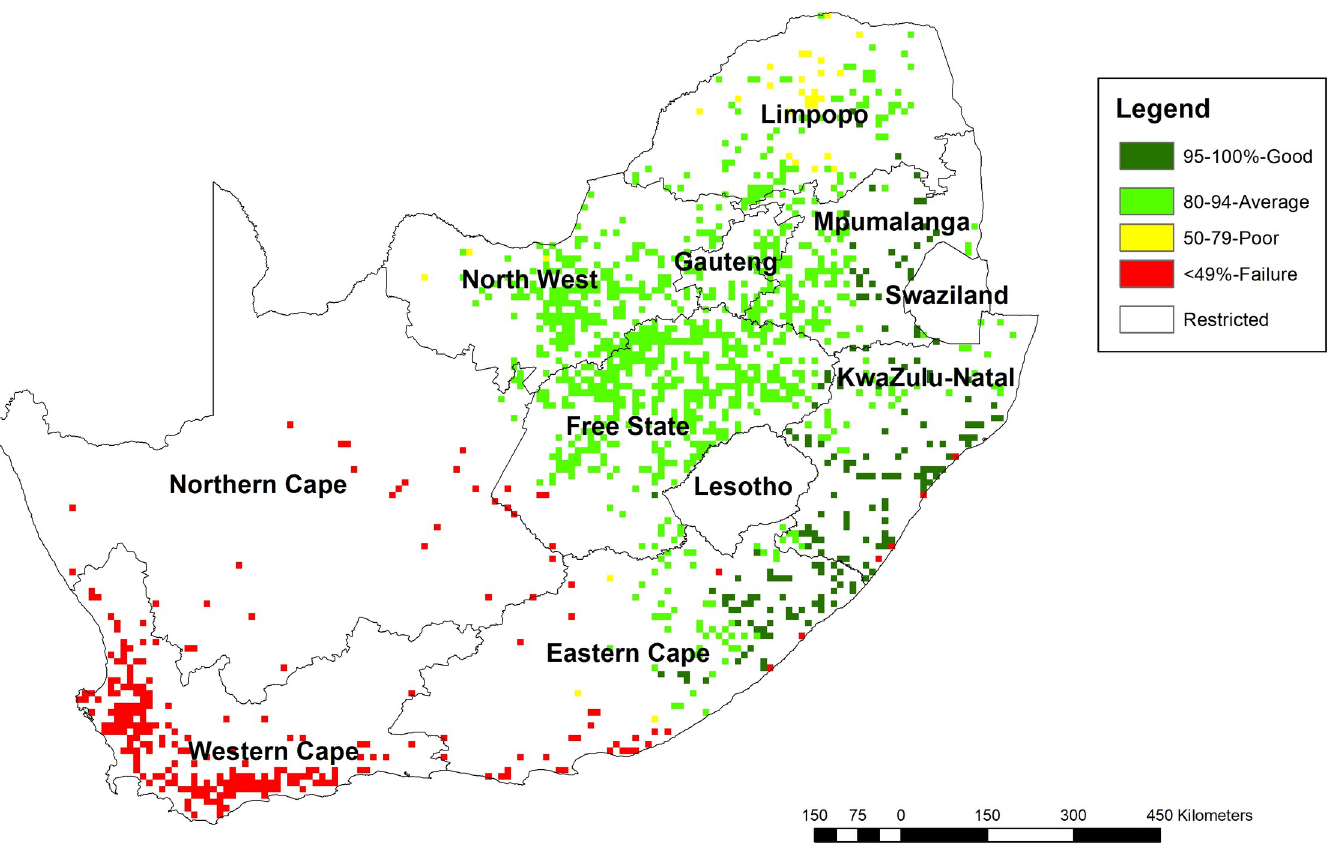
Fig 6. Average water requirement satisfactory indices for a period of 1981 to 2017 in cropping lands in South Africa. [Source, Famine Early Warning Systems Network, (https://earlywarning.usgs.gov/fews, and from USGS Earth Explorer https://earthexplorer.usgs.gov/ and from USGS Earth Explorer https://earthexplorer.usgs. gov/), in ArcGIS 10 . 5]